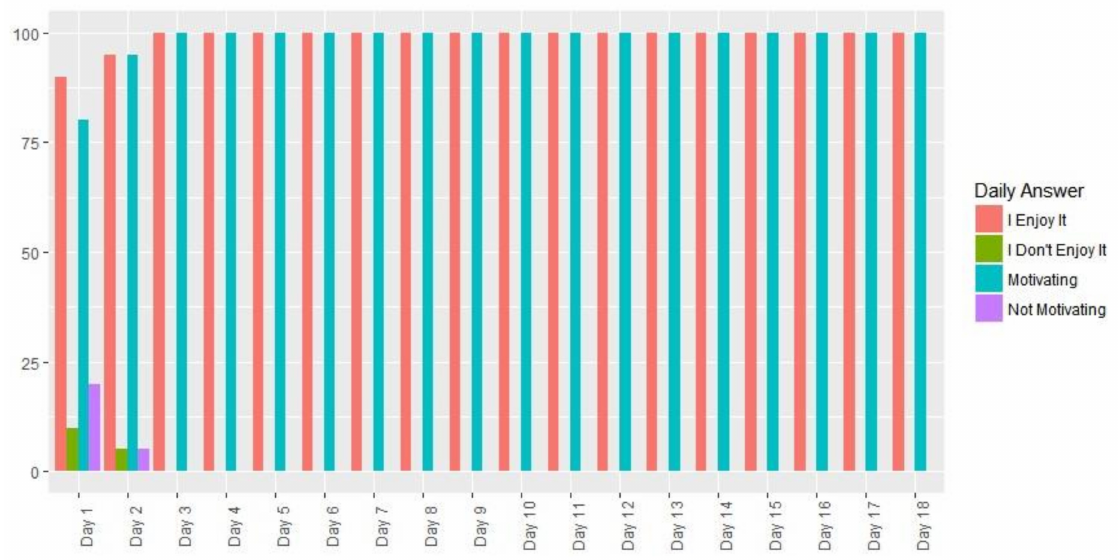
Figure 15. Daily response percentages by the study group to the questions: “Do you like the game?” and Do you find it motivating for the purpose of improving your physical